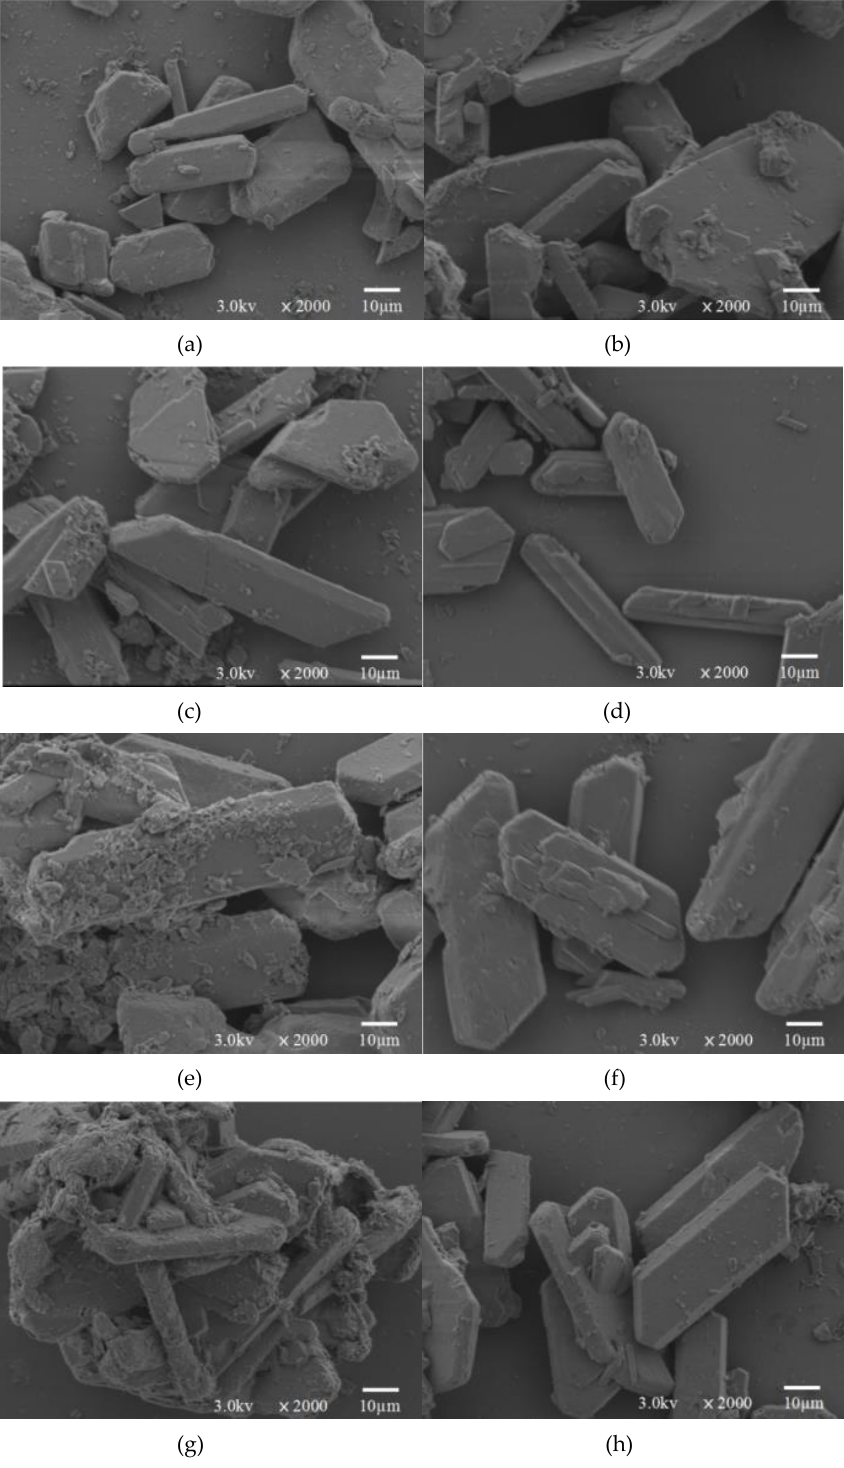
Figure 4. Effect of surfactants on phosphogypsum crystal. a. SEM of gypsum crystals without surface Figure 4. E ff ect of surfactants on phosphogypsum crystal. ( a ) SEM of gypsum crystals without surface active agent. b . SEM of gypsum crystals with SDBS. c. SEM of gypsum crystals with SDS d. SEM of active agent. ( b ) SEM of gypsum crystals with SDBS. ( c ) SEM of gypsum crystals with SDS ( d ) SEM of gypsum crystals with SR. ( e ) SEM of gypsum crystals with PDMS. ( f ) SEM of gypsum crystals with gypsum crystals with SR. e. SEM of gypsum crystals with PDMS. f. SEM of gypsum crystals with SDBS + SDS. ( g ) SEM of gypsum crystals with SDBS + SR. ( h ) SEM of gypsum crystals with SDBS + SDBS+SDS. g . SEM of gypsum crystals with SDBS+SR. h. SEM of gypsum crystals with SDBS+PDMS.